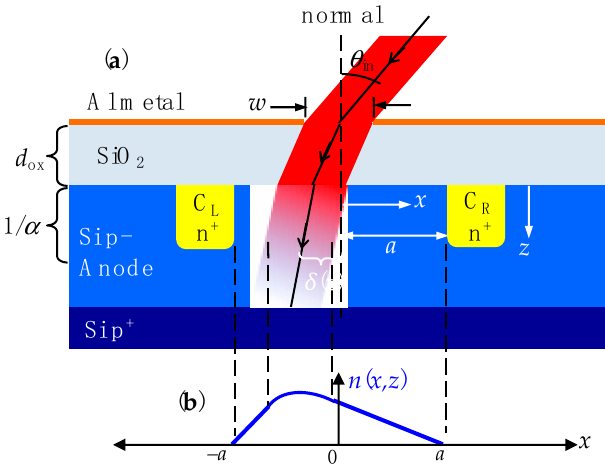
Figure 1. ( a ) Illustration (not to scale) of the angular displacement sensor cross-section. ( b ) The functional form of photoelectron density n ( x , z ) as a function of x at a fixed z . The light is locally absorbed in the anode and generates photocarriers in the anode. With